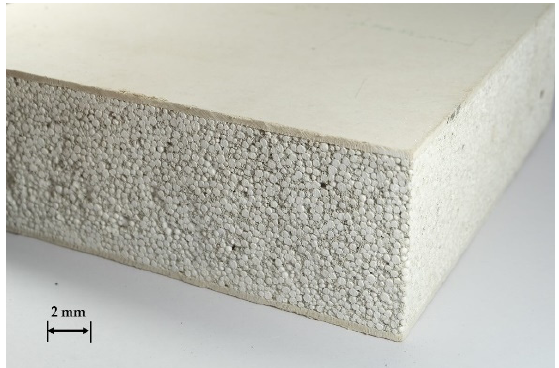
Figure 4. Example of Expandable Polystyrene Concrete Sandwich Wall.